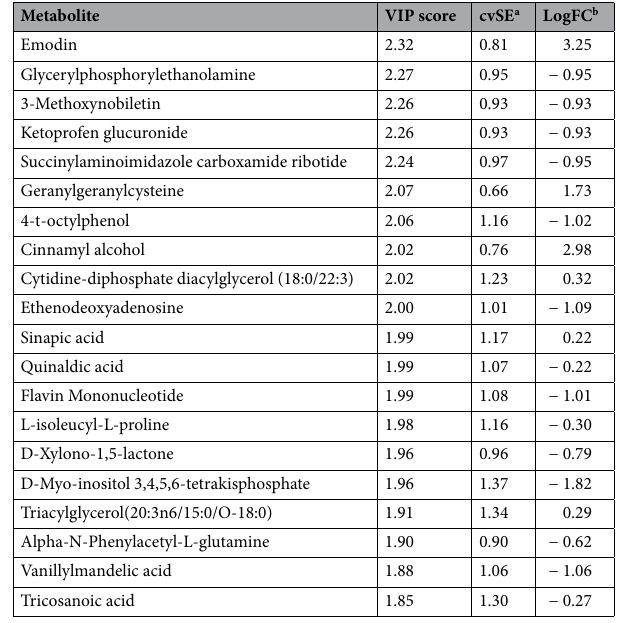
Table 2. Most discriminant compounds (according to variable importance in projection [VIP]) between plasma samples collected 7 days from dry-off (DFD) in dairy cows receiving 10 g/d of lyophilized Aloe arborescens Mill. (AL) considering ‒ 7 to 7 days from dry-off or in the control group (CTR). a cvSE, cross- validation standard error. b LogFC, logarithm of Fold-Change values.